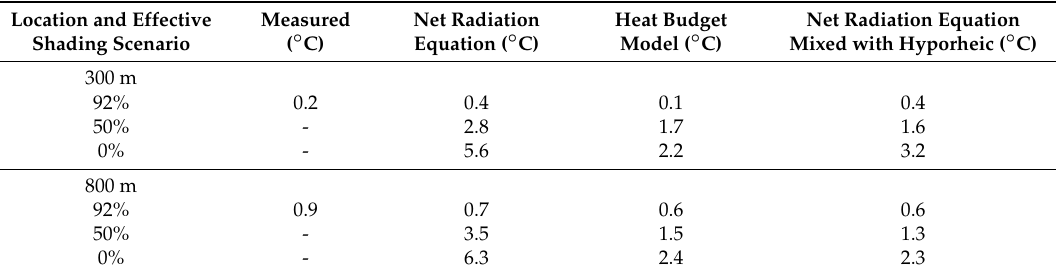
Table 5. Average change in maximum stream water temperatures for current condition of 92% effective shade and predicted conditions of 50% and 0% effective shade from locations 0 to 300 m and 300 m to 800 m on Little